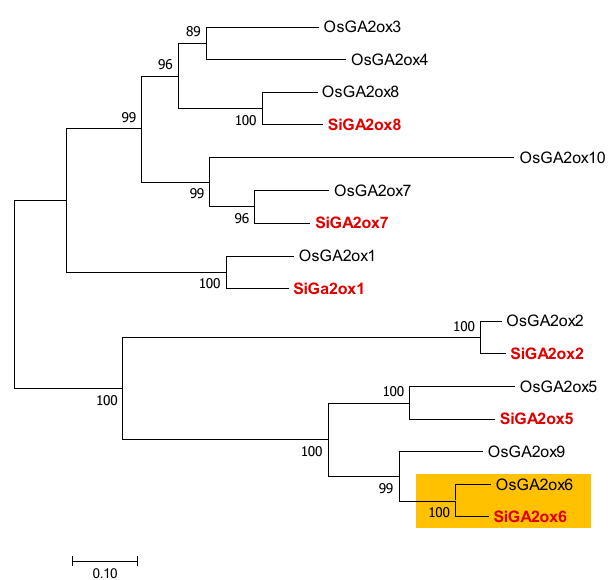
Figure 7. Evolutionary relationships of OsGA2ox and SiGA2ox . The candidate gene chosen for expression analysis is shown within the box.